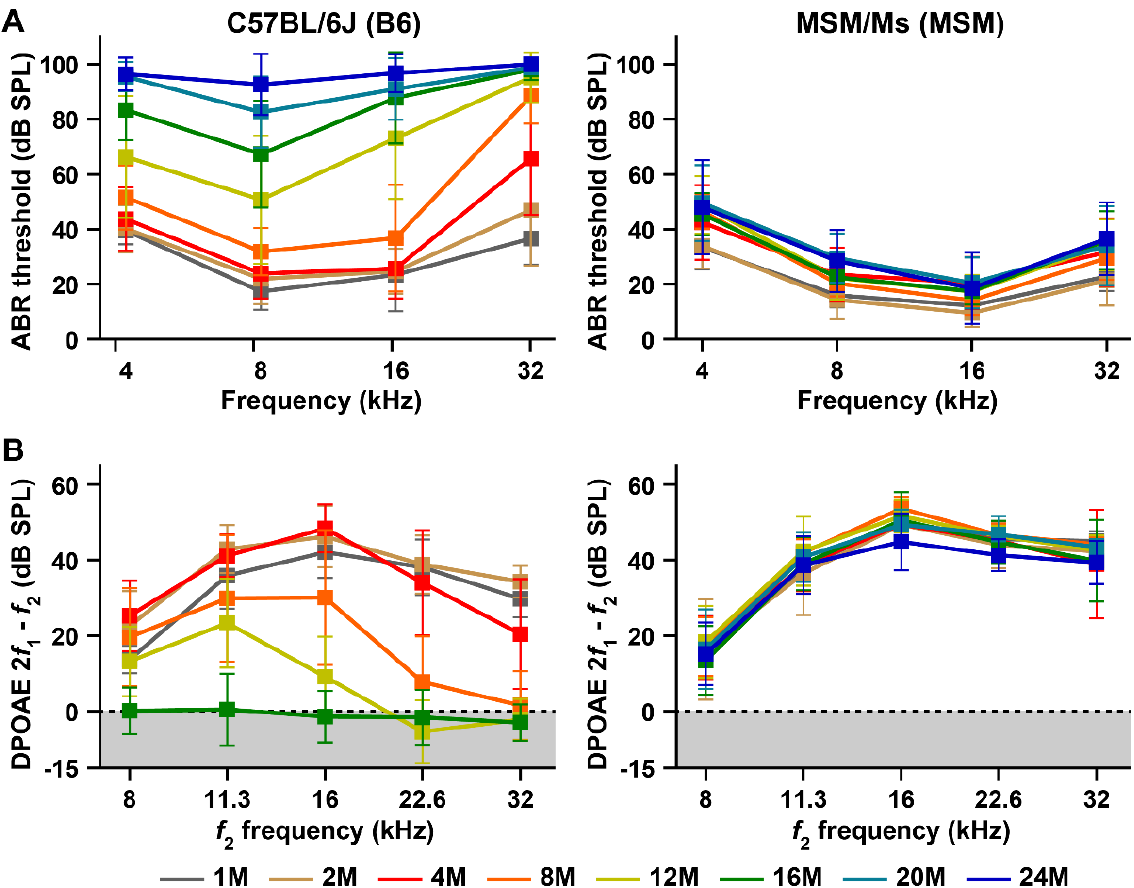
Figure 1. Characterization of age-related hearing loss (ARHL) in C57BL/6J (B6) and MSM/Ms (MSM) strains by measurements of the ABR thresholds and DPOAE amplitudes: ( A ) Comparisons of ABR thresholds among the ages (in months) in the B6 and MSM strains. ABR thresholds at 4, 8, 16, and 32 kHz sound stimuli were measured in male mice at 1 (B6, n = 10; MSM, n = 10), 2 (B6, n = 15; MSM, n = 12), 4 (B6, n = 15; MSM, n = 15), 8 (B6, n = 14; MSM, n = 11), 12 (B6, n = 15; MSM, n = 14), 16 (B6, n = 12; MSM, n = 11), 20 (B6, n = 16; MSM, n = 10), and 24 (B6, n = 10; MSM, n = 10) months of age. ( B ) Comparisons of DPOAE amplitudes in the B6 and MSM mice of different ages (in months). The DPOAE amplitudes (2 f 1 - f 2 ) against the f 2 frequencies at 8, 11.3, 16, 22.6, and 32 kHz were recorded in male mice at 1 (B6, n = 10; MSM, n = 11), 2 (B6, n = 12; MSM, n = 15), 4 (B6, n = 15; MSM, n = 15), 8 (B6, n = 14; MSM, n = 12), 12 (B6, n = 15; MSM, n = 12), 16 (B6, n = 10; MSM, n = 10), 20 (MSM, n = 9), and 24 (MSM, n = 10) months of age. The means (squares) and SDs (error bars) of the ABR thresholds and DPOAE amplitudes are shown in each line graph. The noise floors (gray zones) are adjusted to 0 dB SPL.